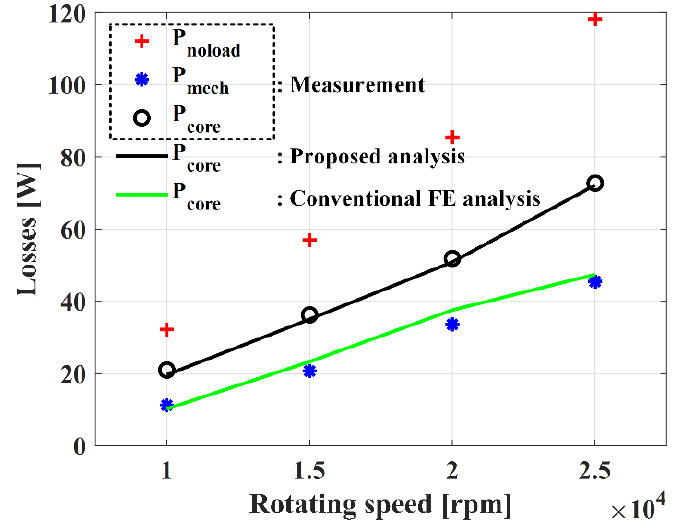
Figure 14. Mechanical and core losses under no-load conditions.